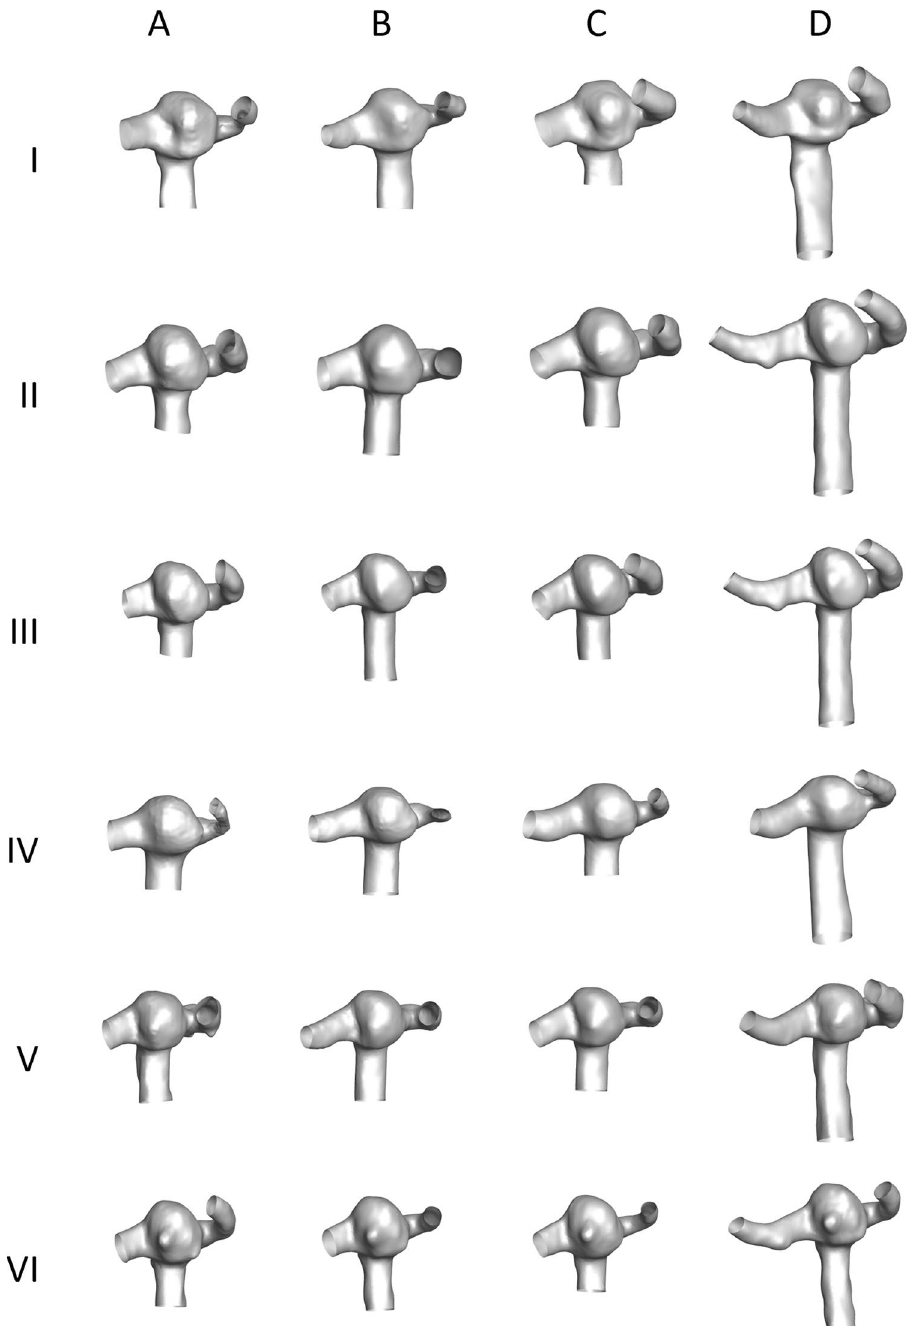
Figure 1. Reconstructed aneurysm geometries. I–VI indicate the time points and A–D indicates